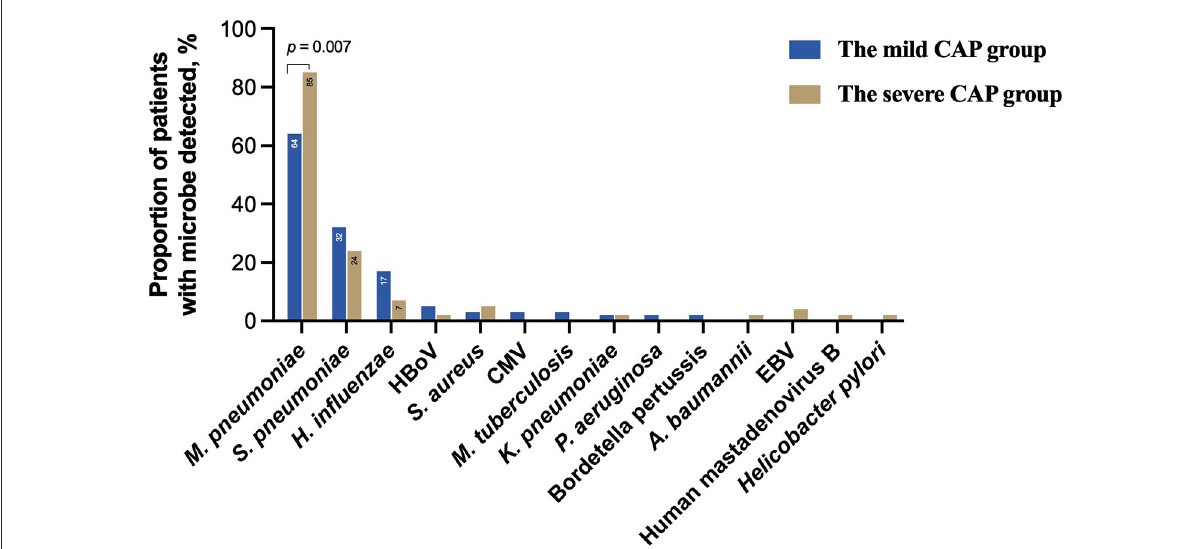
FIGURE6 Clinically determined pathogens spectrum between the mild CAP and severe CAP groups. CAP, community-acquired pneumonia; HBoV, Human bocavirus; CMV, Cytomegalovirus; EBV, Epstein–Barr virus.